Question: Compose a caption that would accompany this figure in a paper.
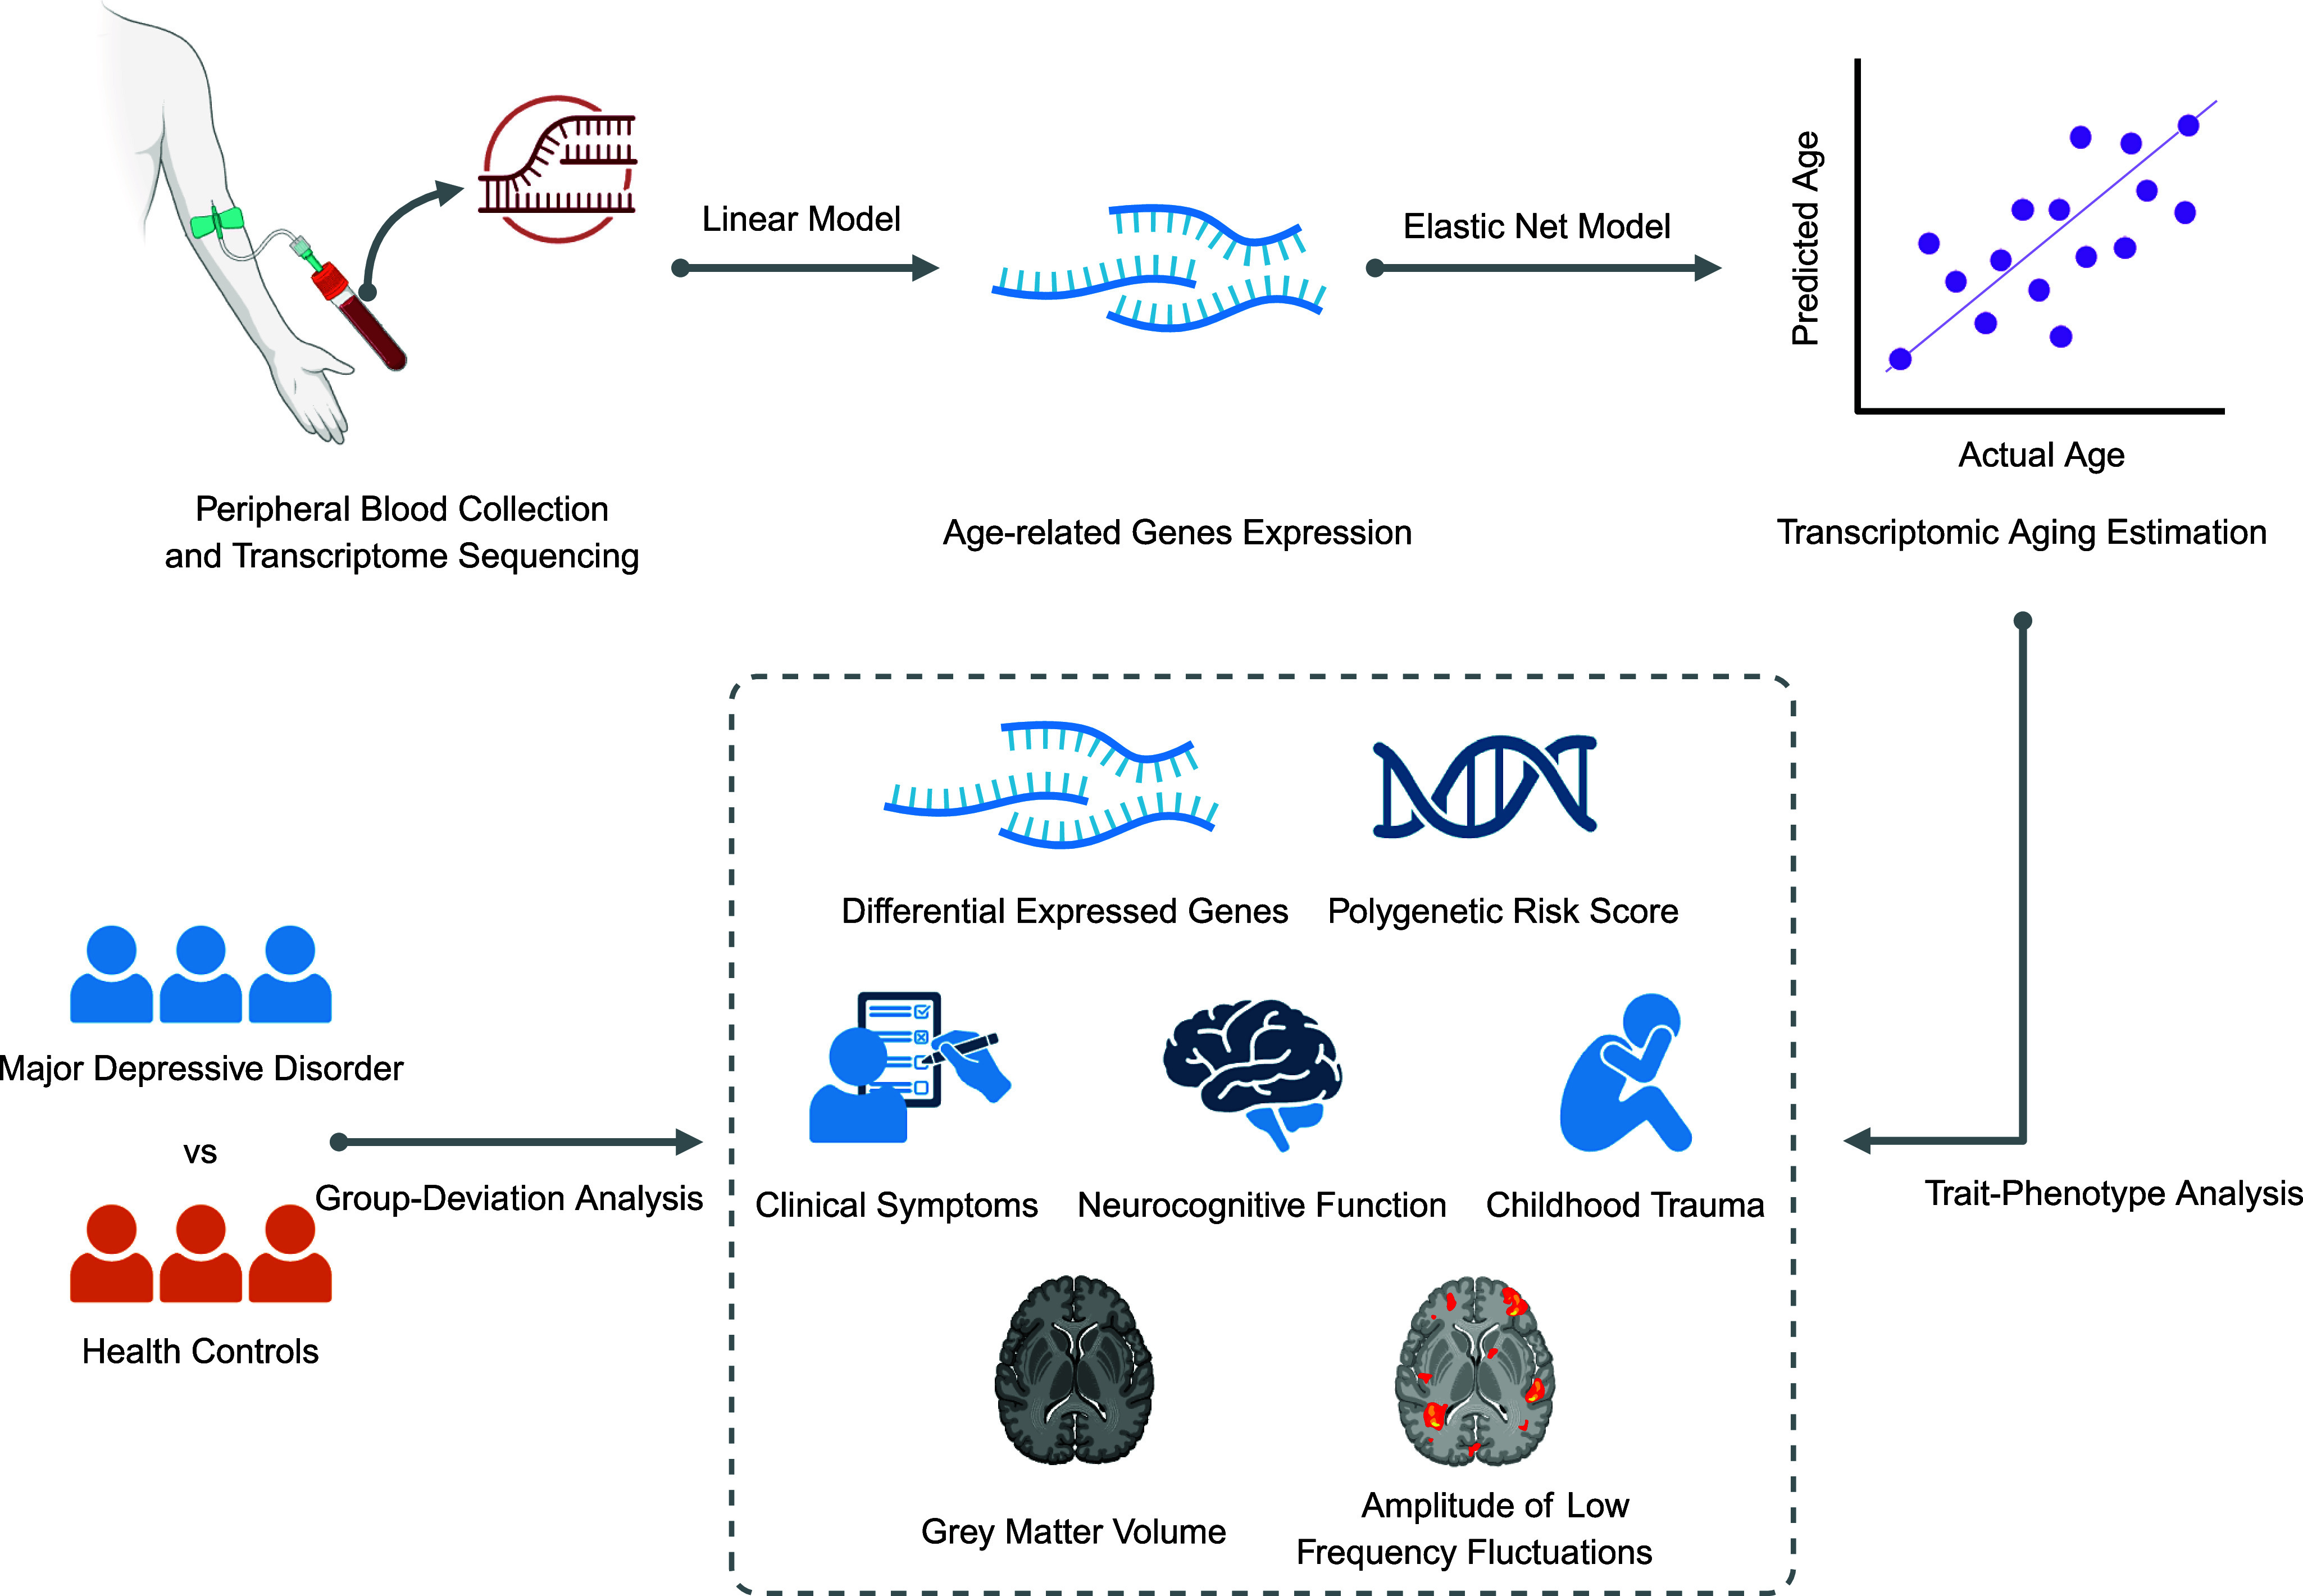
Answer: Overview of study design and analytical framework. Note : Peripheral blood samples were collected for transcriptome sequencing to obtain gene expression profiles. Age-related genes were identified using linear regression models, followed by the construction of an elastic net regression model to predict transcriptomic age. The difference between predicted transcriptomic age and actual chronological age was used to estimate transcriptomic aging. Further analyses were performed to examine group deviations and aging associations in various phenotypes, including differentially expressed genes, polygenic risk scores, clinical symptoms, neurocognitive function, childhood trauma, gray matter volume, and amplitude of low-frequency fluctuations. Figure 1. long description.